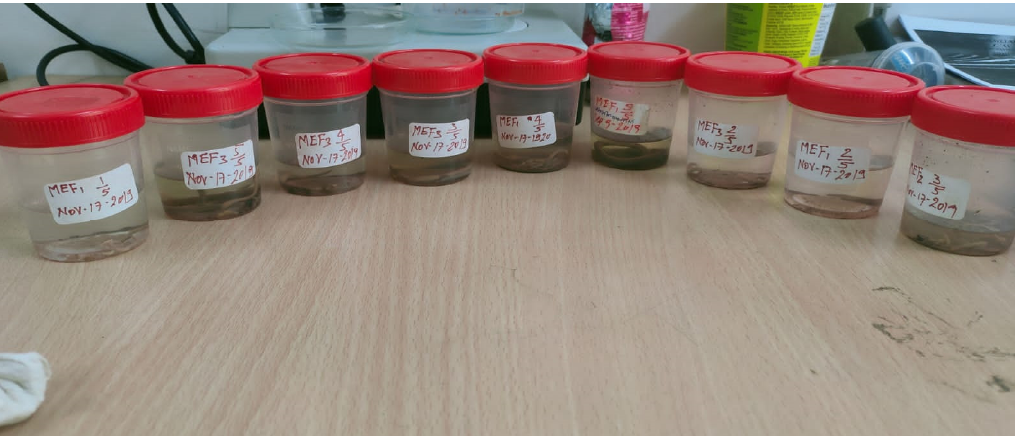
Figure 2. Samples of collected earthworms from different land use systems (Pa, SP, and MEF) (Photo: Kasahun Gudeta).